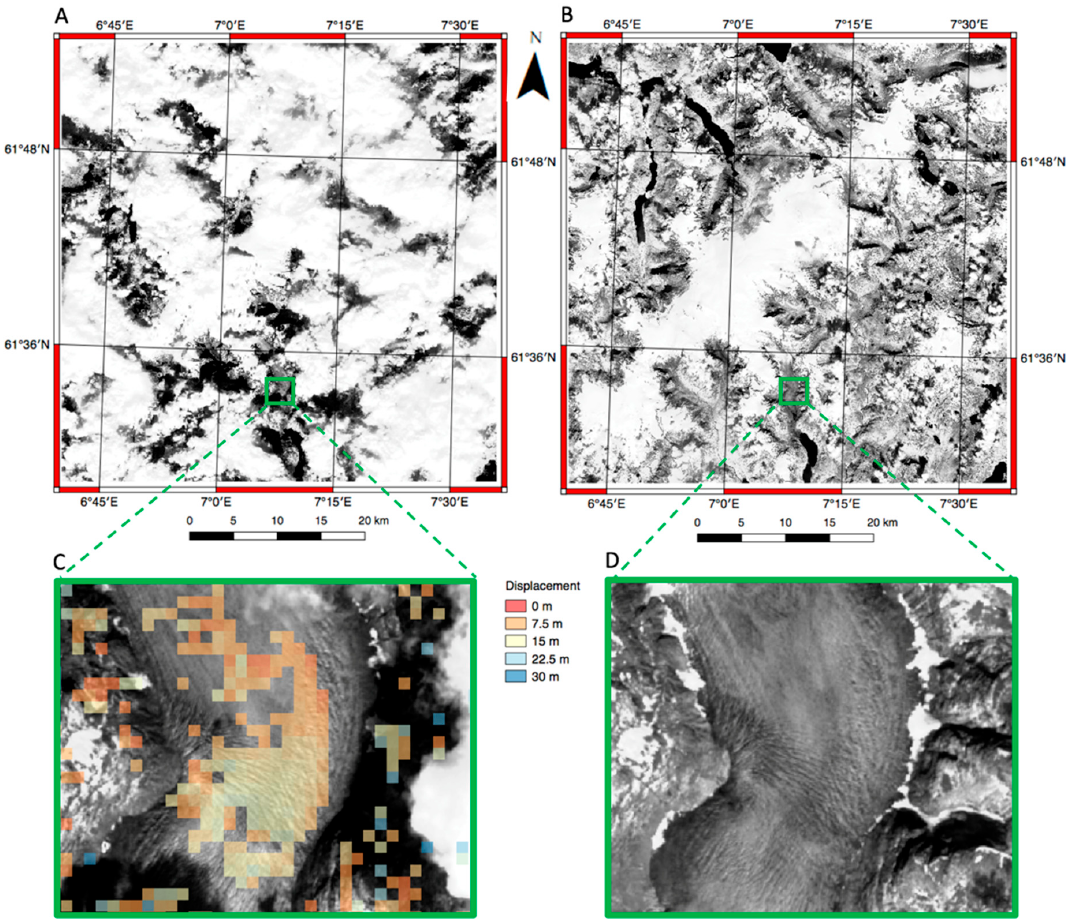
Figure 3. ( A ) Sentinel-2 image of the Jostedalsbreen ice cap from 11.09.2016 with > 75% cloud cover; ( B ) Sentinel-2 image of the Jostedalsbreen ice cap from 23.07.2016 with minimal cloud cover; ( C ) Displacement map using pair 23.07.2016–11.09.2016 over a close-up image of a section of Tunsbergdalsbreen with less cloud coverage than overall scene of 11.09.2016; ( D ) Close-up image of a section of Tunsbergdalsbreen with minimal snow cover and no cloud cover conditions.